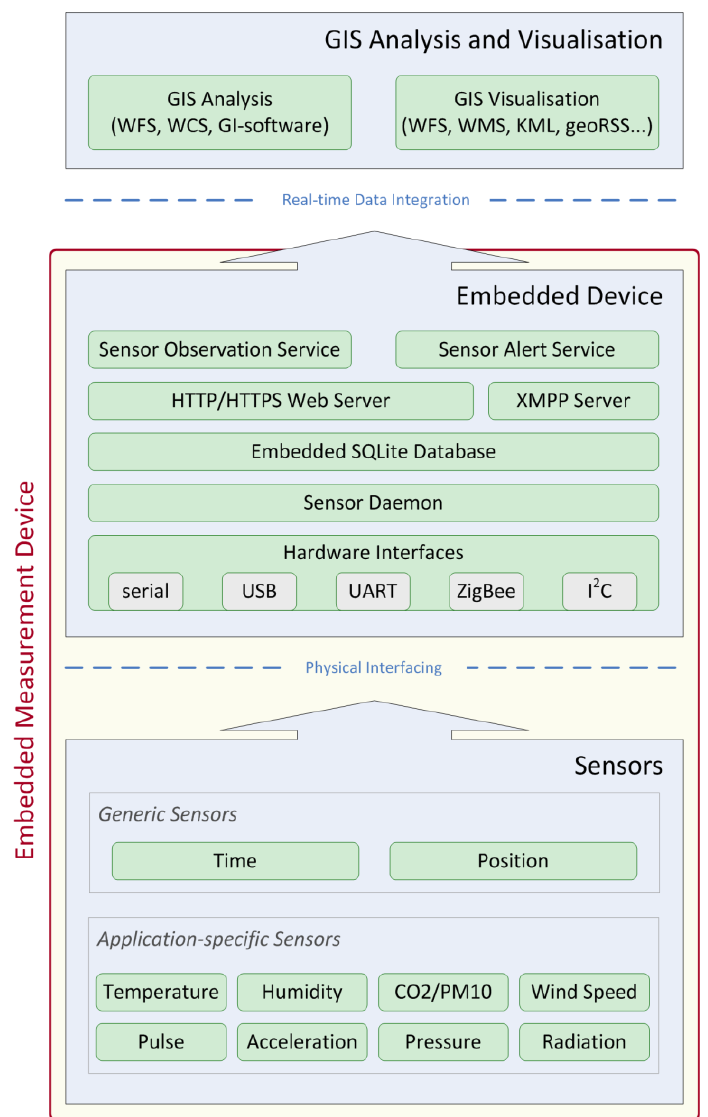
Figure 7. Software Infrastructure on the Embedded Sensing